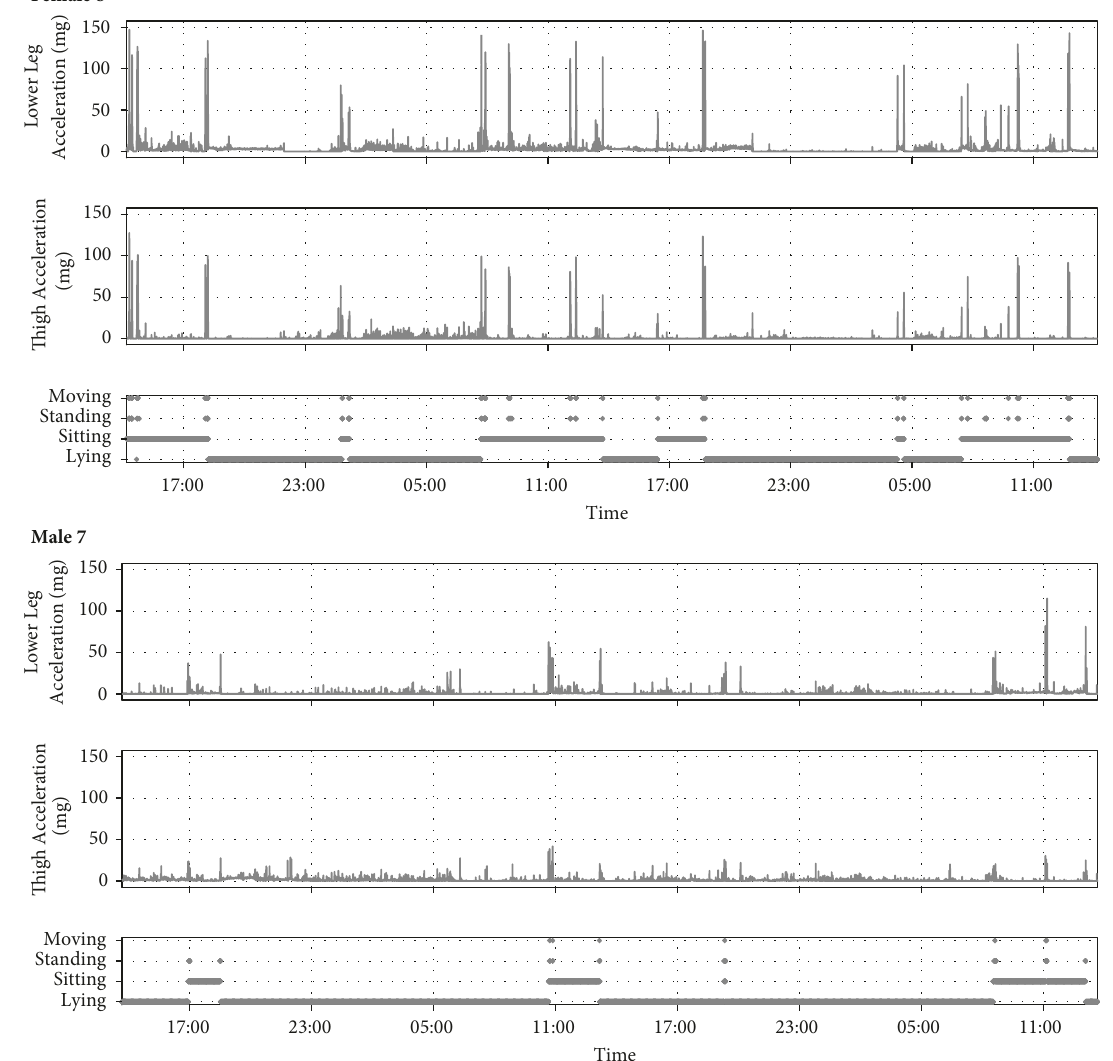
Figure 5: Examples of participant’s activity during study